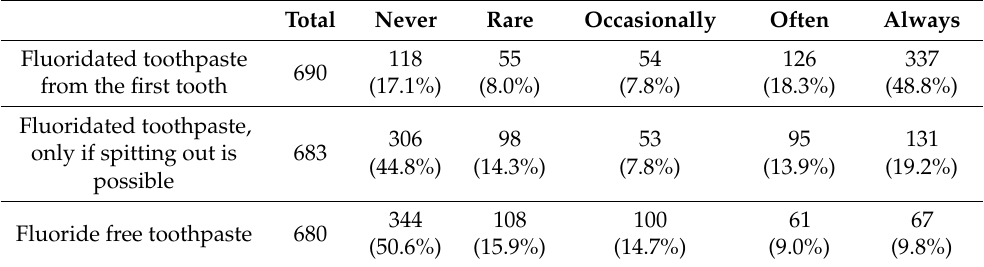
Table 6. Fluoride recommendations of pediatricians in absolute values and in percent